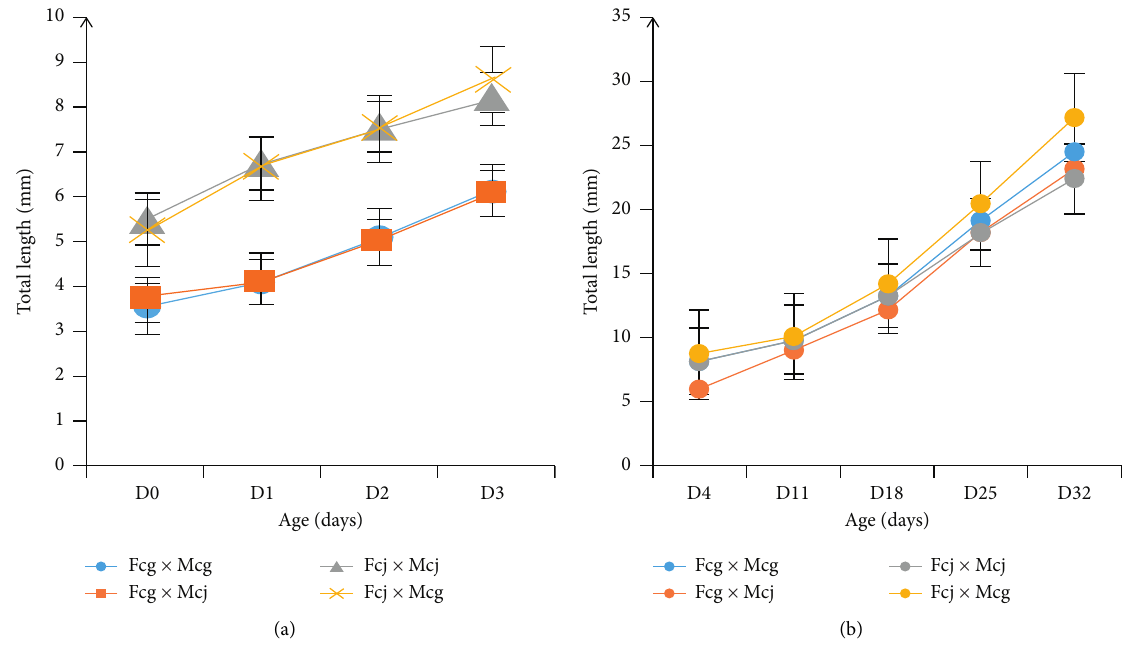
Figure 5: Evolution of total length of larvae for yolk resorption (a) and rearing (b) in reciprocal hybridizations of Clarias gariepinus × Clarias jaensis in controlled conditions. Ɨ : standard deviation; the female was named